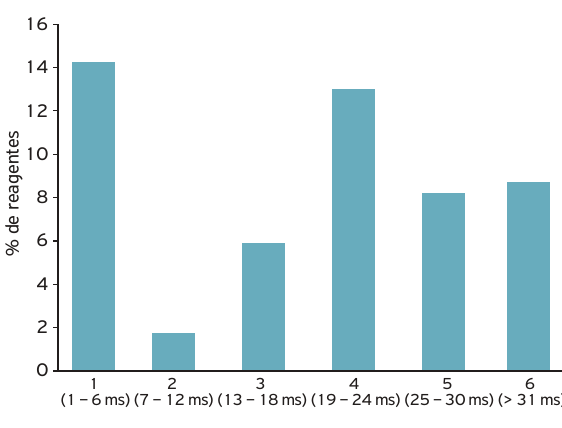
Gráfico 3. Percentual de bovinos com anticorpos contra as PNC segundo idade. LVB, 2002 a 2012. São Paulo,